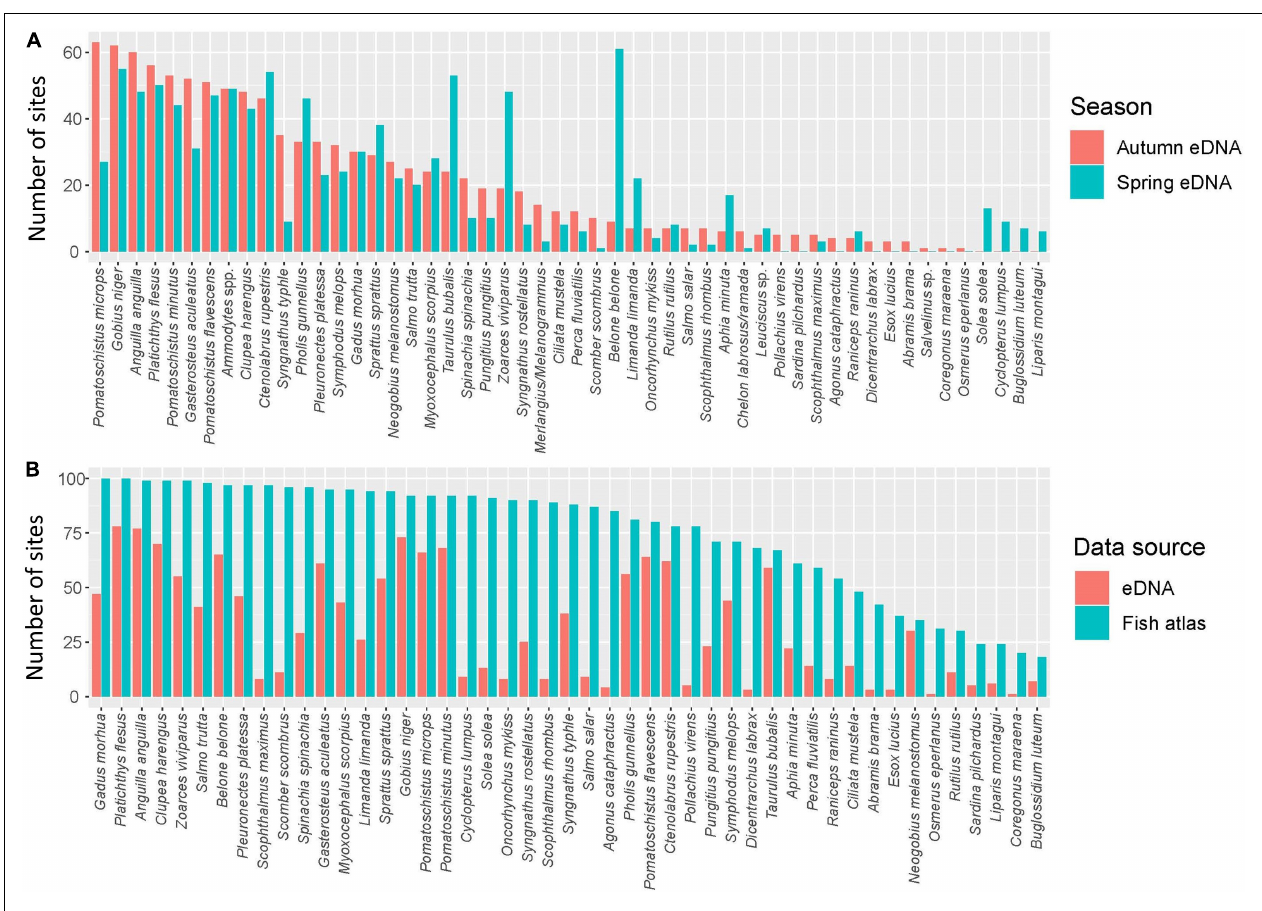
FIGURE 2 | The number of locations each species occurs in. (A) Occurrence patterns between the two seasons autumn (blue) and spring (red). (B) Accumulated occurrence patterns from eDNA for both seasons (red) and the Fish Atlas (blue). For the comparison between the fish atlas and both seasons, only species that were identified to species level were included, with the exception of Ammodytes spp. and Salvelinus